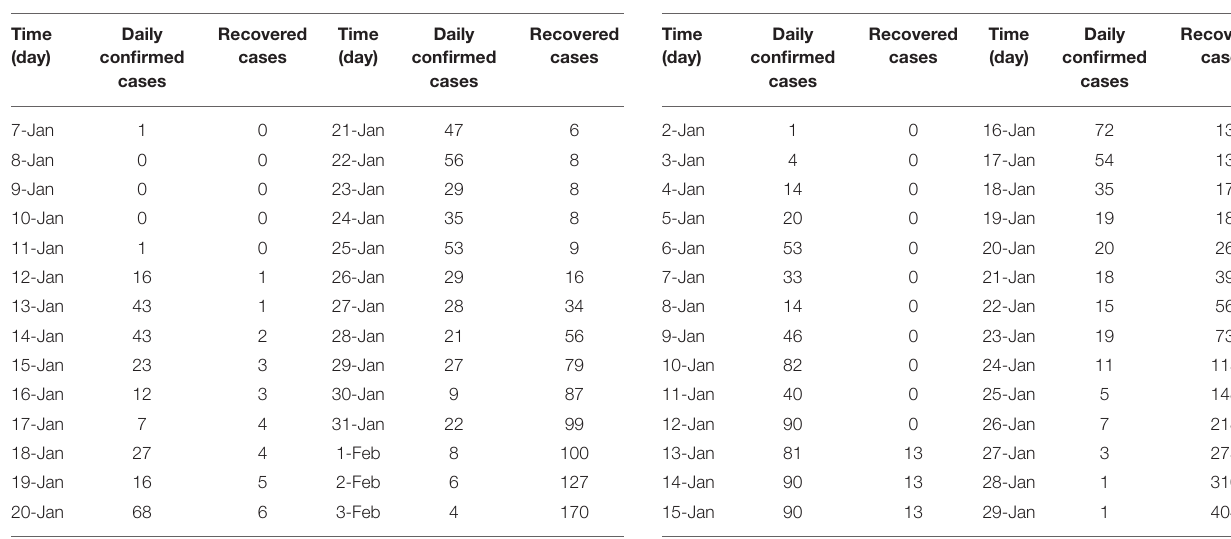
TABLE 2 | Daily confirmed and recovered cases of Hebei during the outbreak in January 2021.